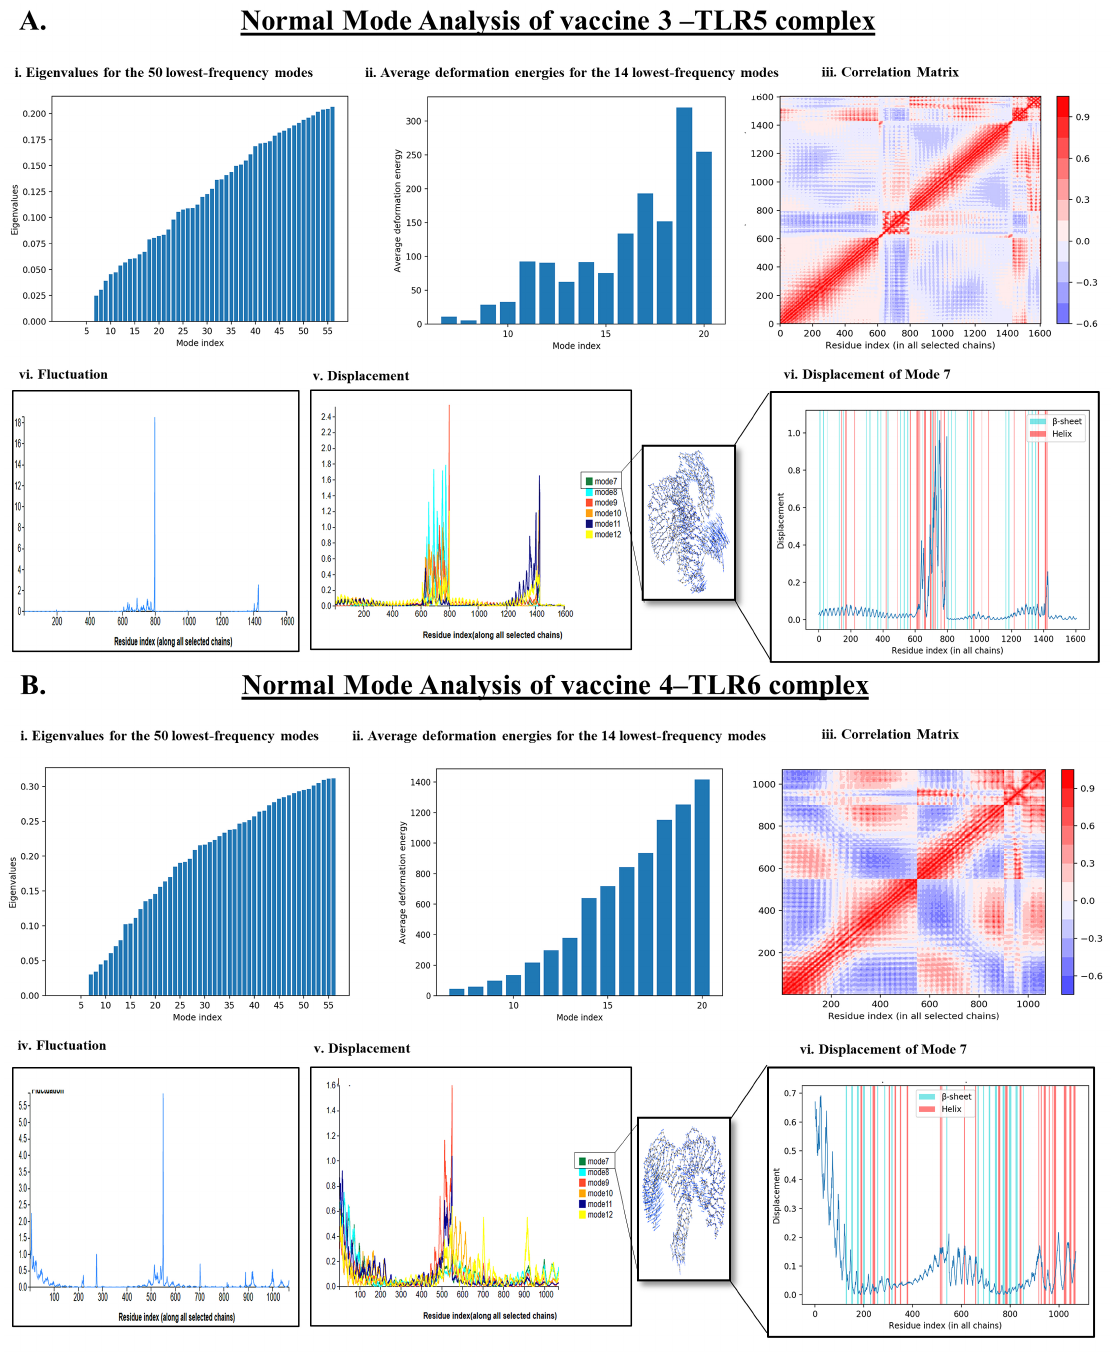
Figure 4. Normal mode analysis depicting the stability and flexibility of the docked structures ( A ). NMA of VACCINE 3–TLR 5 complex depicting ( i ). Eigenvalues, ( ii ). Average deformation energies of different modes, ( iii ). correlation matrix, ( iv ). Fluctuation plot, ( v ). Displacement plot, and ( vi ). Displacement of the best mode (mode 7). ( B ). NMA of VACCINE 4–TLR-6 complex representing the different plots for ( i ). Eigenvalues, ( ii ). Average deformation energies of different modes, ( iii ). Correlation matrix, ( iv ). Fluctuation plot, ( v ). Displacement plot, and ( vi ). Displacement of the best mode (mode